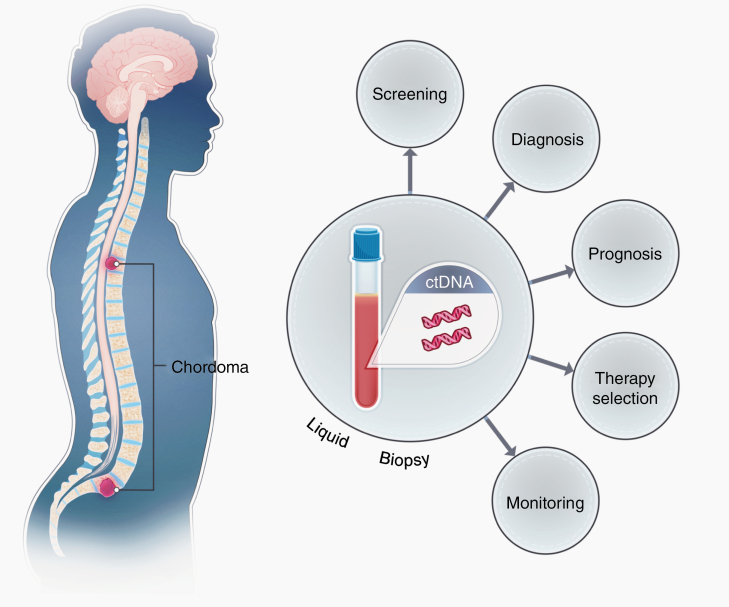
Schematic demonstrating the shedding of ctDNA derived from spinal chordomas in the plasma of patients. Chordomas shed DNA containing mutations into systemic circulation, allowing for non-invasive screening and recurrence monitoring by liquid biopsy techniques such as ddPCR and RACE-Seq. Prognostic and/or therapeutic information may also be imparted by liquid biopsy, depending on the nature of the mutation identified.